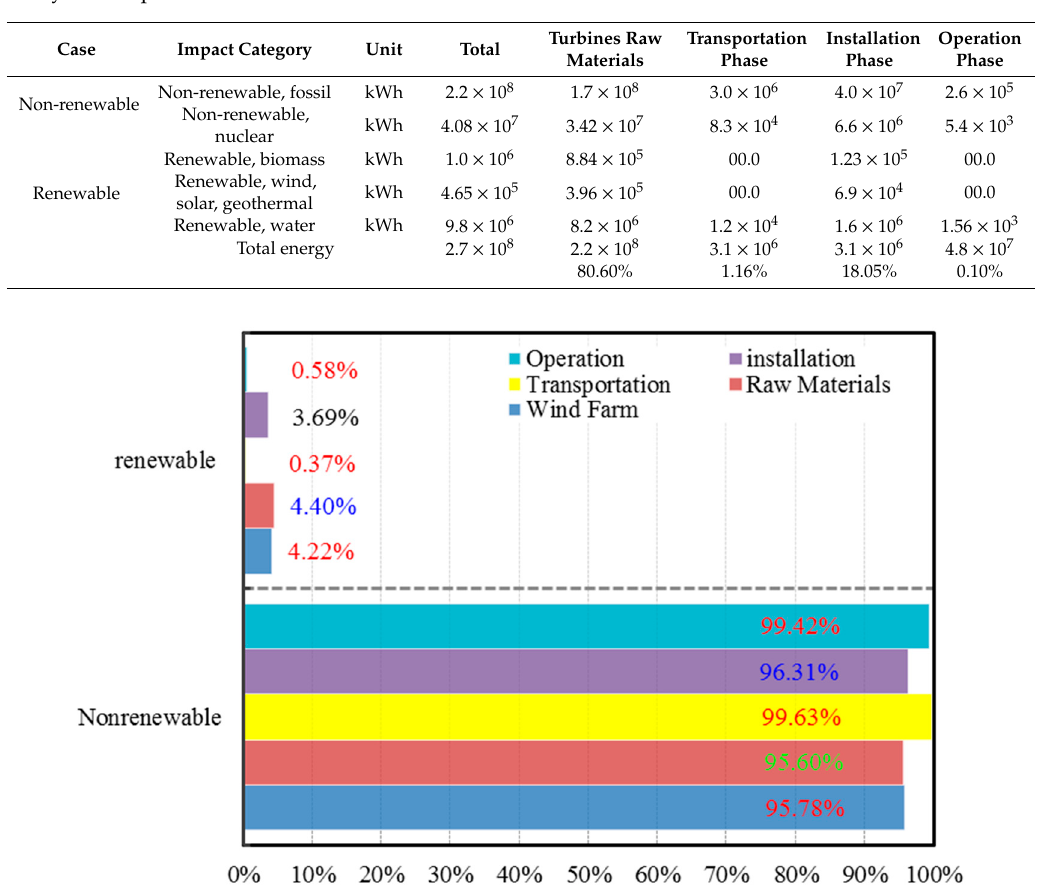
Figure 5. Cumulative energy demand (CED).